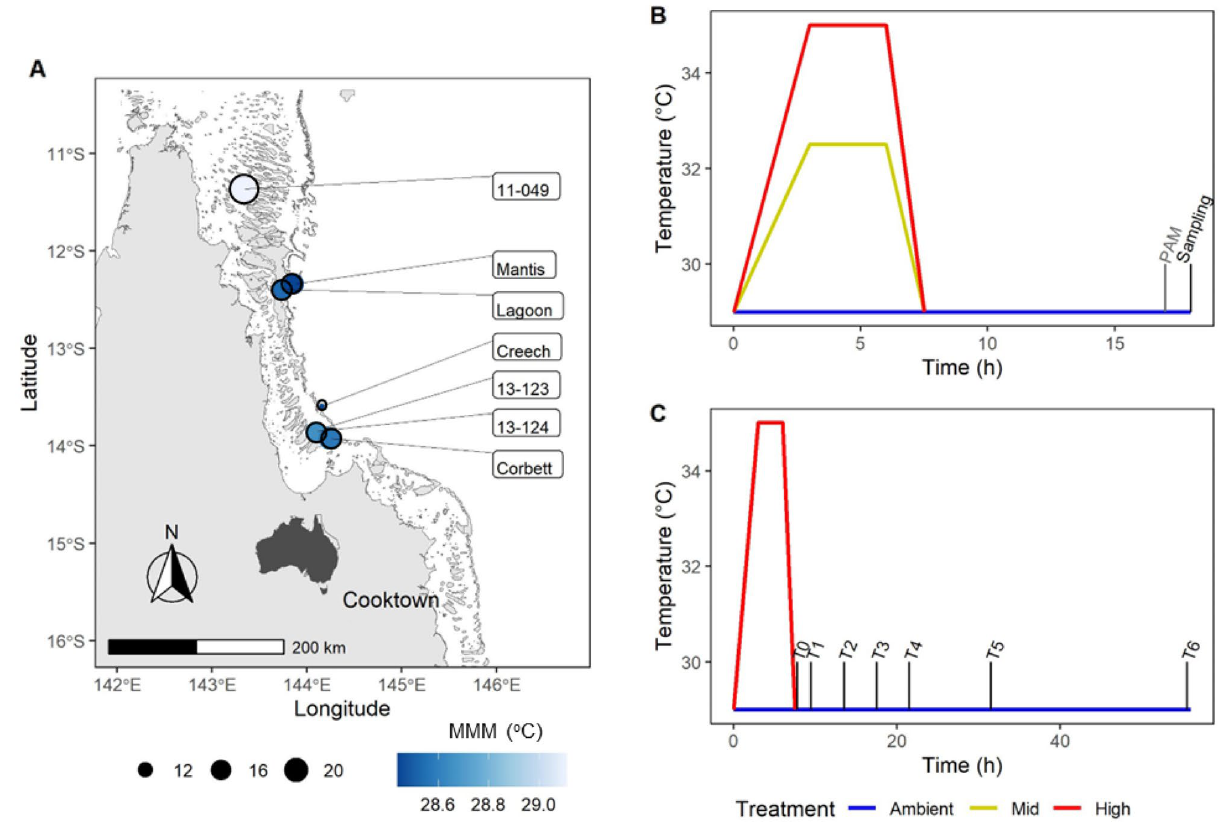
Figure 4. Collection and experimental designs used to examine the influence of fragment size on two species ( A. tenuis and P. damicornis ) and time of sampling on multiple physiological measures. ( A ) Map of sampling locations, size of dot indicates number of colonies sampled per site and colour shows Max Monthly Mean (MMM) temperature of each site. Map generated in R version 4.1.3. ( B ) Temperature profiles used to test for size effects in A. tenuis and P. damicornis (ambient and high treatments only, experiment 1) and to investigate multiple physiological measures across five reefs in A. tenuis (all three treatments, experiment 3). ( C ) Temperature profile and sampling time points for assessing changes in physiological metrics through time (experiment 2).